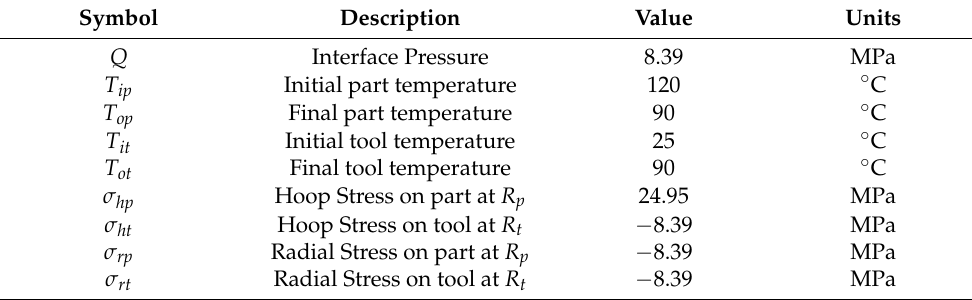
Table 7. Descriptions of output variables and values for M5 core pin.